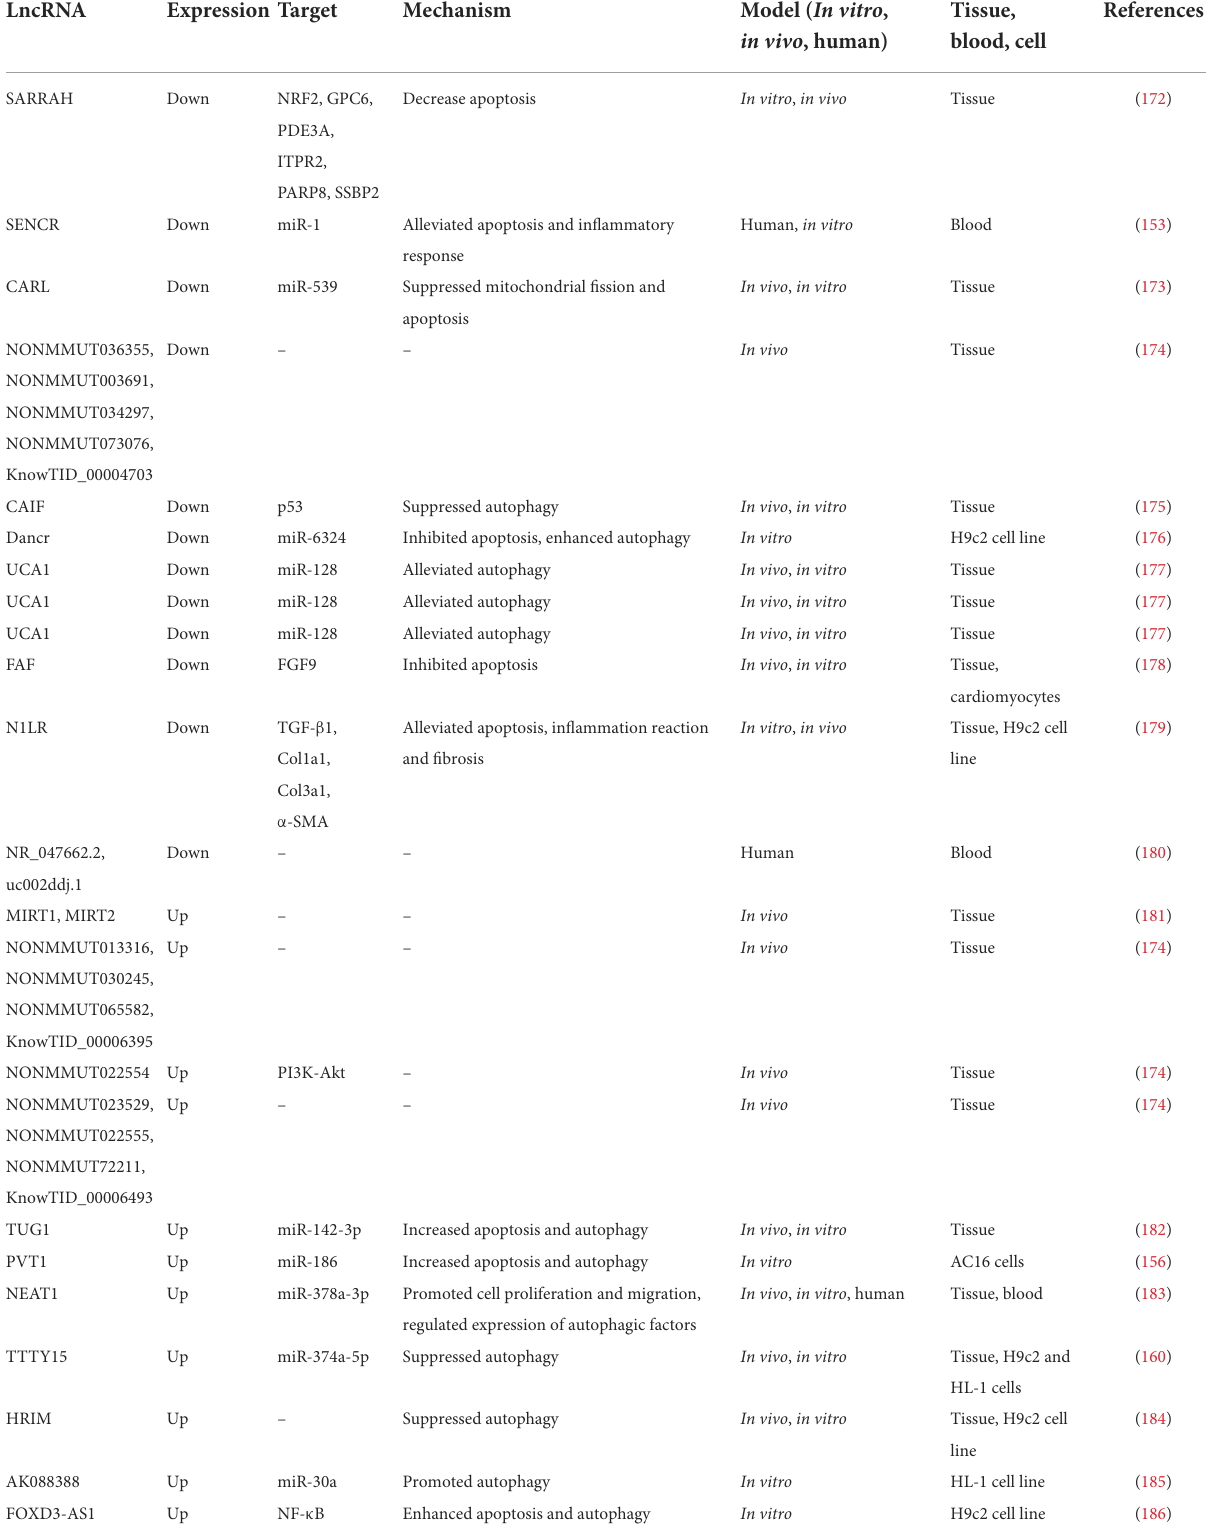
TABLE 2 Reports of changes in lncRNA expression in laboratory models and patients with MI.